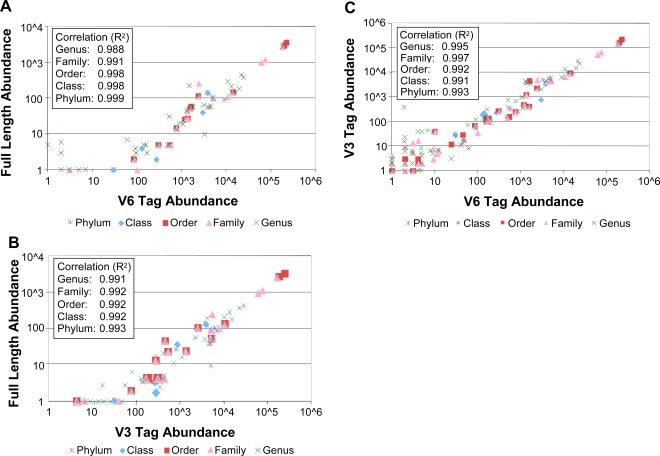
Correlation of taxonomic assignments for human gut sequences based on full-length SSU rRNA, V3 and V6 variable regions.At each taxonomic level, the number of sequences from a particular taxon using one sequencing strategy (e.g., V6 tags) is plotted against the number of sequences from that same taxon using a second sequencing strategy (e.g., full-length SSU rRNA genes). For instance, classifying to the genus level, the Clostridial genus Ruminococcus occurred 186 times in the full-length SSU rRNA sequences and 19,332 times in the V6 tags. The order Clostridiales occurred 3,613 times in the full-length sequences, and 217,482 times in the V6 tags. Note: correlations are linear, although the axes use log scales for clarity. Figure 3A compares V6 tags with full-length sequences, Figure 3B compares V3 tags with full-length sequences, and Figure 3C compares V6 and V3 tags.